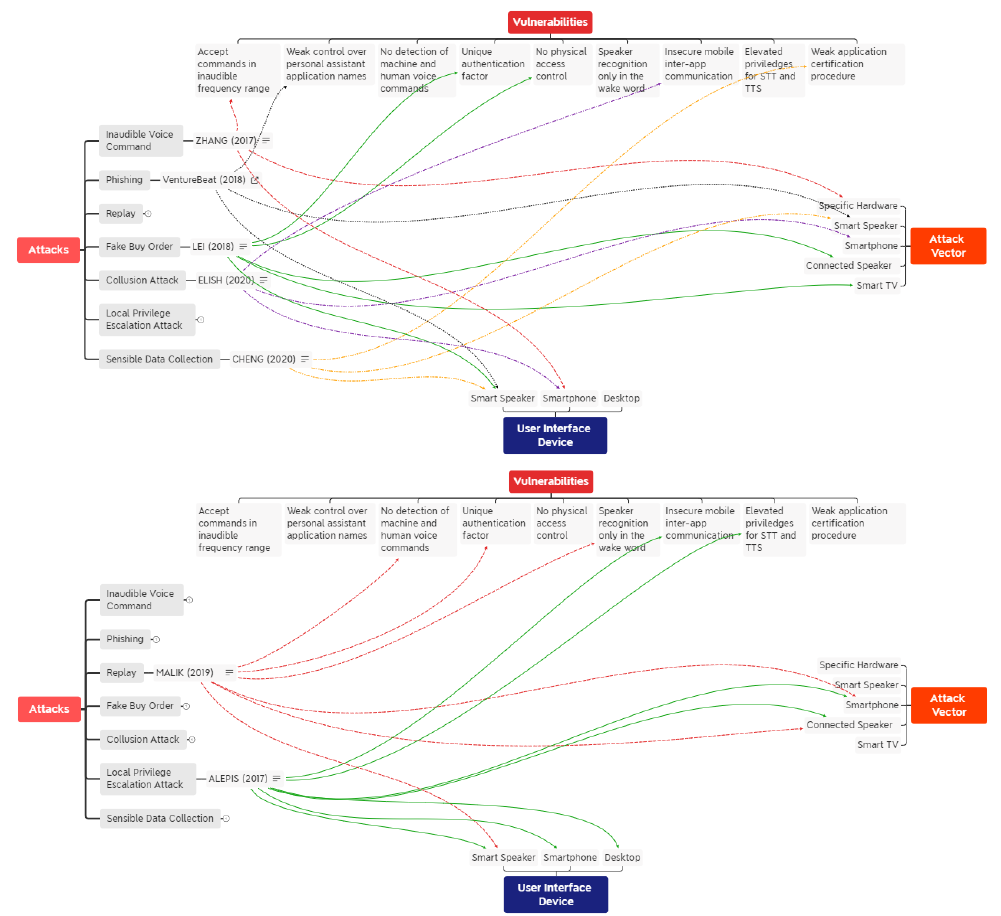
Figure 3. Attack relationships with Vulnerabilities, User Interface Device, and Attack Vector. Inaudi- ble command, phishing, fake buy, collusion and sensible data collection attacks are illustrated in the top panel. Replay and local privilege escalation attacks are illustrated in the bottom